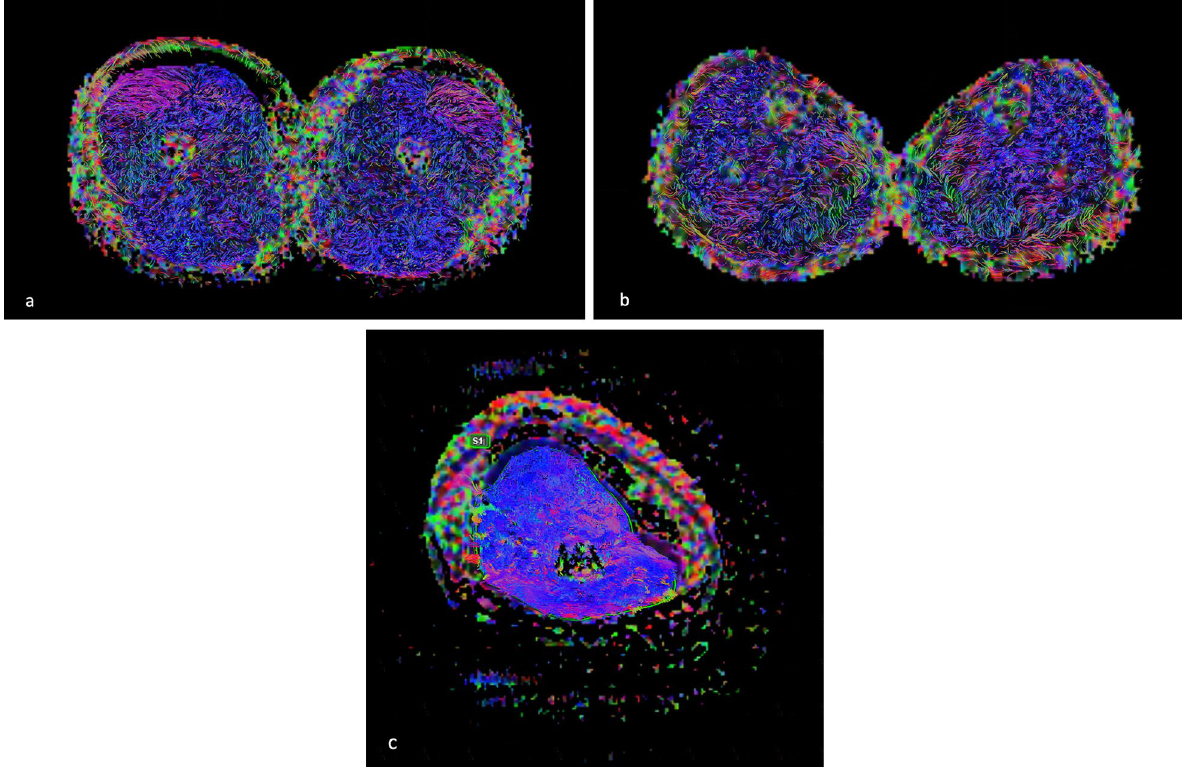
Fig. 2 Axial color FA map with overlaid tractography of the thighs ( a ), legs ( b ), and arm ( c